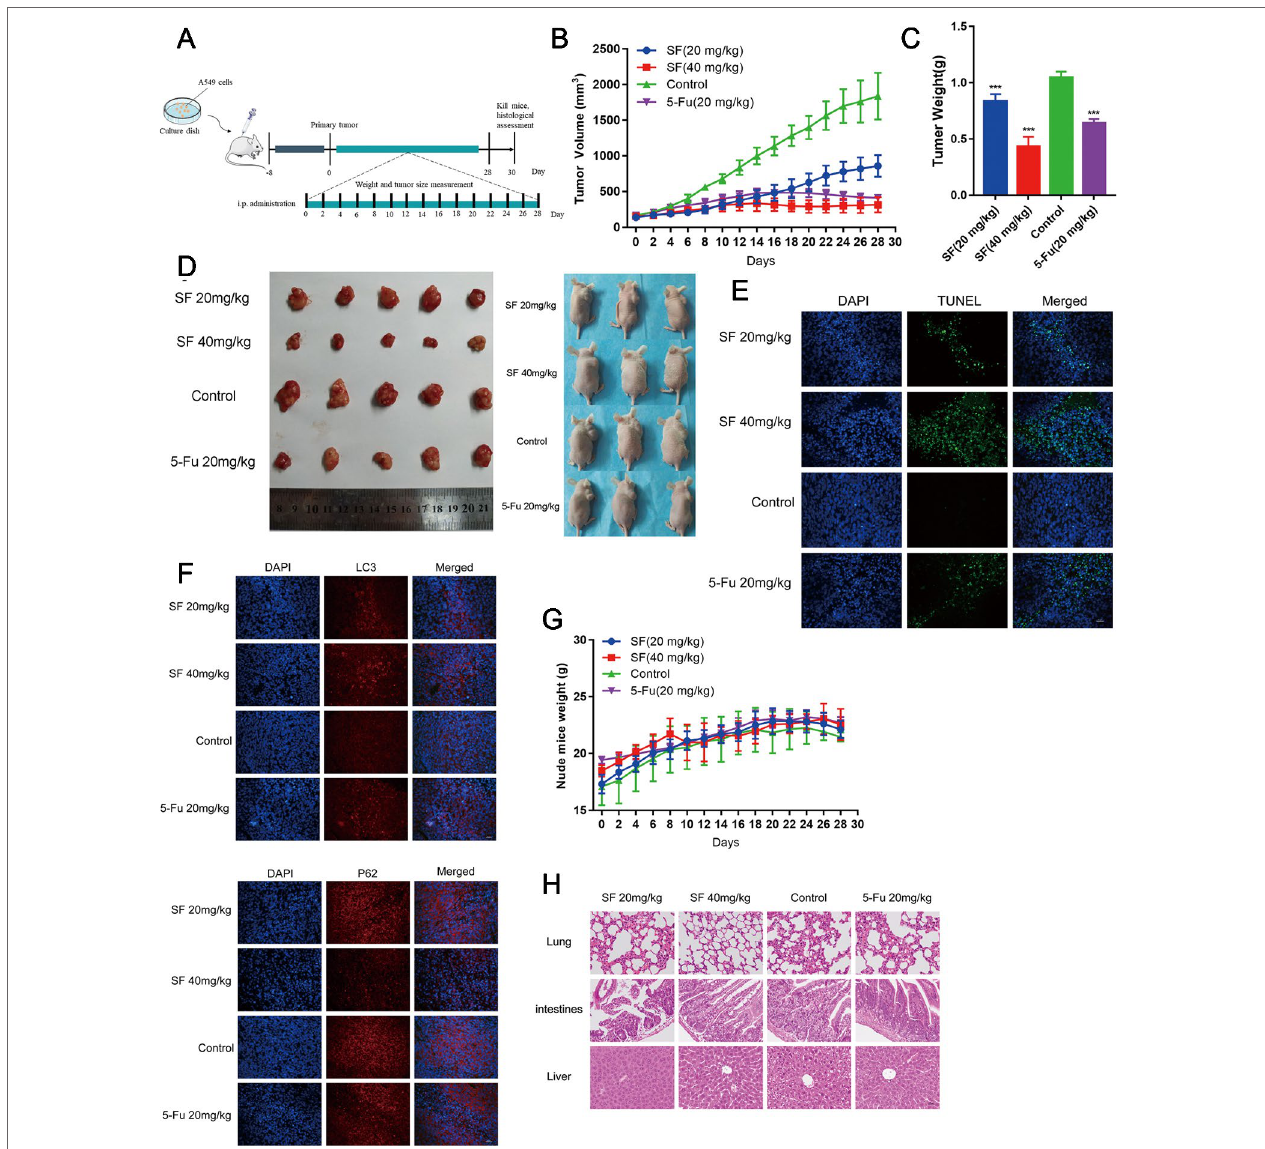
FIgURe 6 | Sotetsuflavone inhibits the growth of xenograft mice bearing A549 tumors in vivo . (A) Establishment of xenograft mice bearing A549 tumors and the drug administration method. (B) Tumor volumes were measured and calculated every 2 days. (C) Tumor weight in the control group, 5-Fu (20 mg/kg), sotetsuflavone treatment groups (20 mg/kg, 40 mg/kg) (*** p < 0.001 vs. control). (D) A549 cells were subcutaneously inoculated into the back of nude mice. The figure at the right side of the image showed the representative size of the four groups of tumors. (e) TUNEL staining (green) in tumor tissues; DNA was stained by DAPI (blue). (F) Representative images showed immunofluorescence staining of LC3 and P62. (g) The weight of nude mice was recorded every 2 days. (h) H&E stained the tumors, lungs, intestines, and livers of mice from each group, whereby the pathological changes of mice were observed, and the toxicity of sotetsuflavone was evaluated. Scale bars, 50 µm.